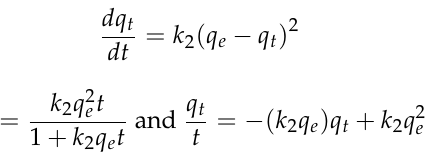
Table 2. Chemical composition of red clay. 169